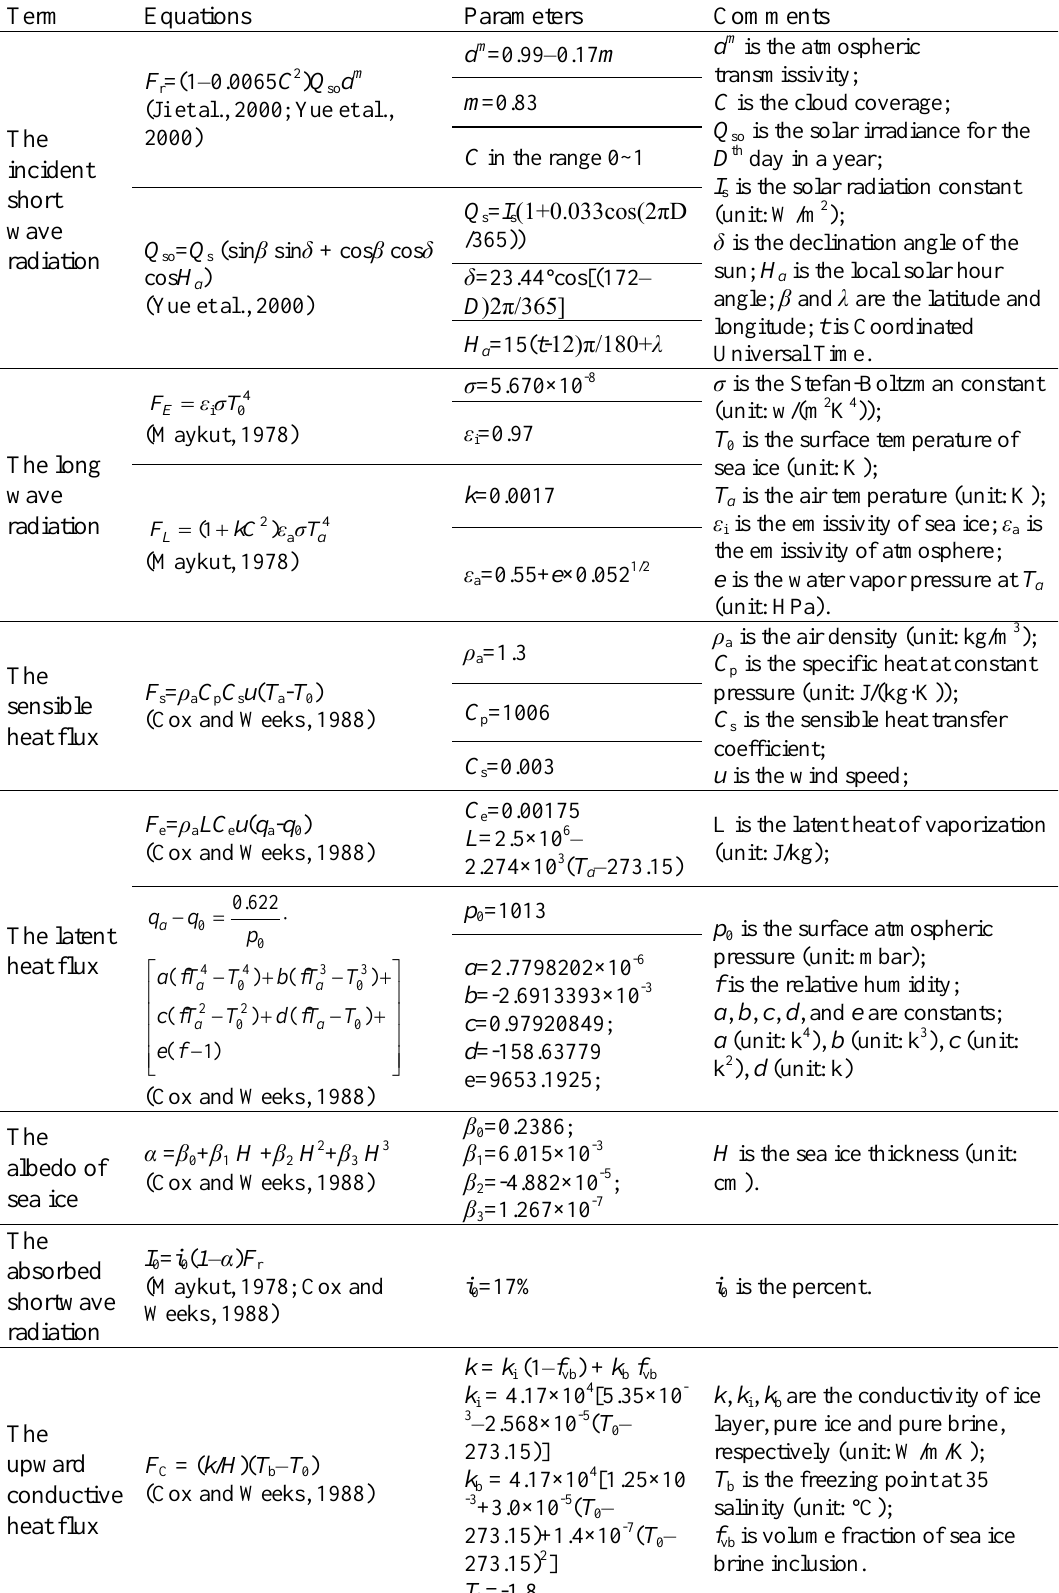
Table 1. Equations and parameters used for the sea ice thermodynamic